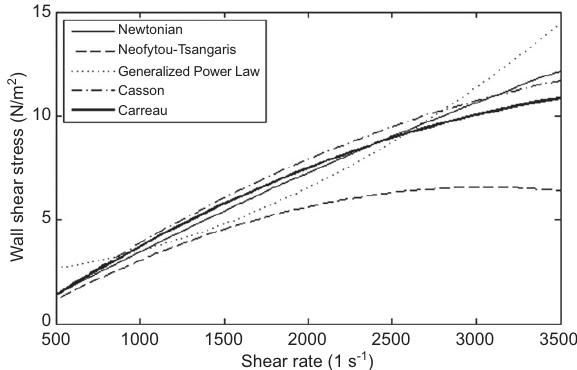
Figure 4 WSS vs. percent dilation for various models, with 0.11196 m/s inflow rate.